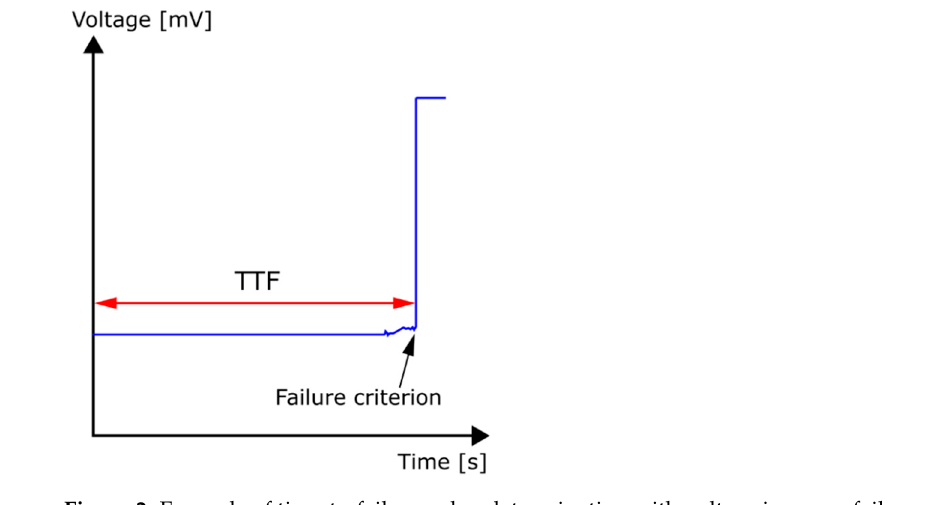
Figure 2. Example of time-to-failure value determination with voltage jump, as failure criterion.